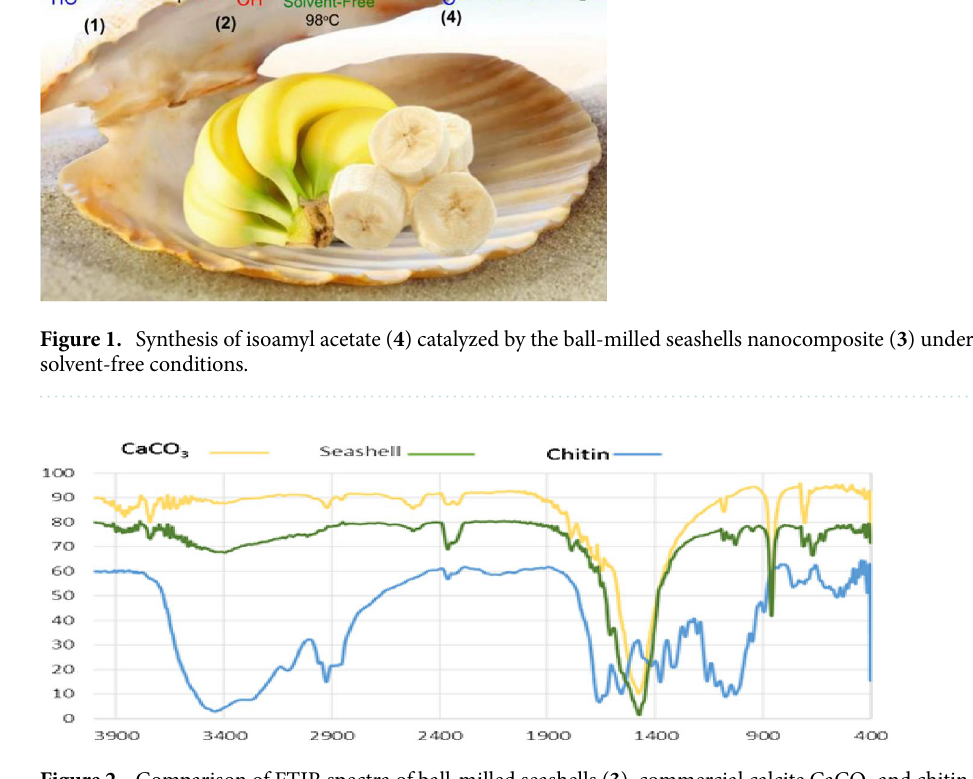
Figure 2. Comparison of FTIR spectra of ball-milled seashells ( 3 ), commercial calcite CaCO 3 and chitin.